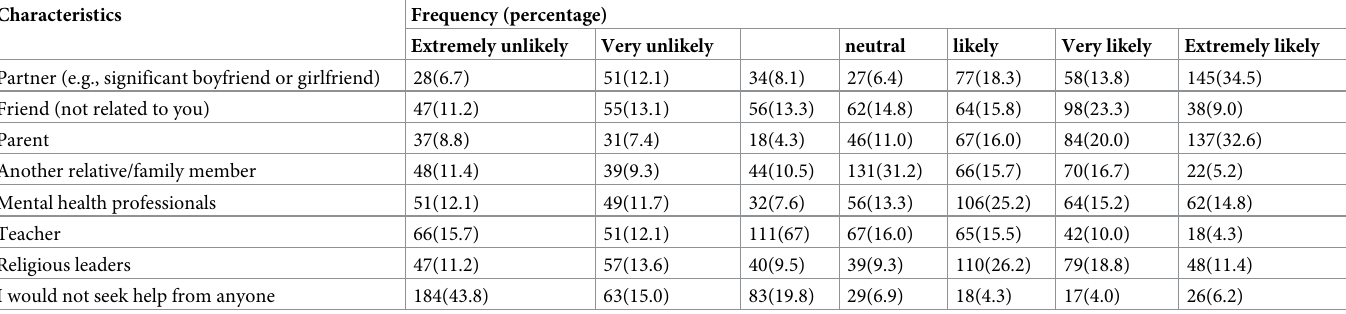
Table 3. Help-seeking behavior of the respondents towards mental health and mental health problems at Jimma Zone, Seka Chekorsa district, Oromia, Ethiopia, March 2020.